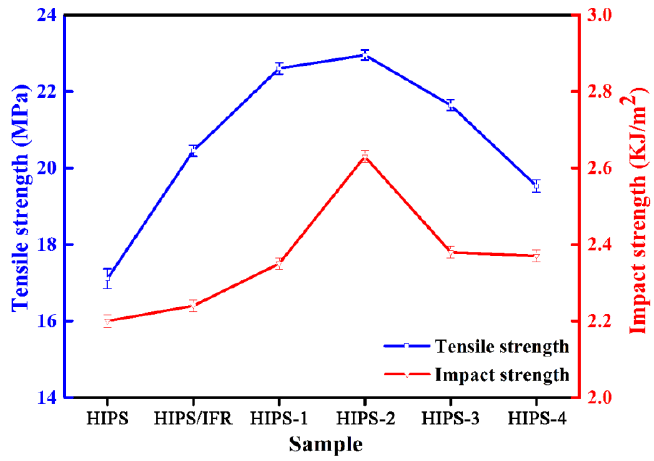
Figure 4. The tensile strength and impact strength of the HIPS compounds.